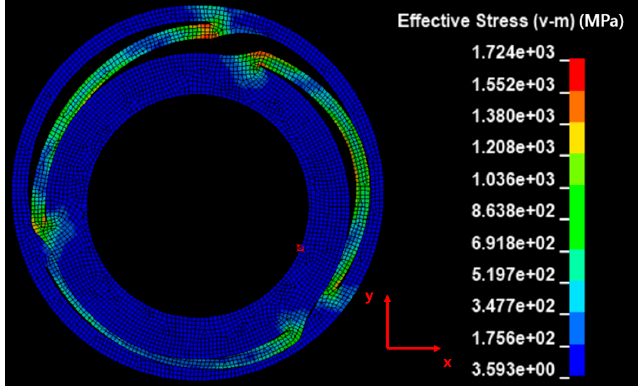
Figure 11. FFT for residual vibration (residual vibration area from Figure 9) in the frequency domain.